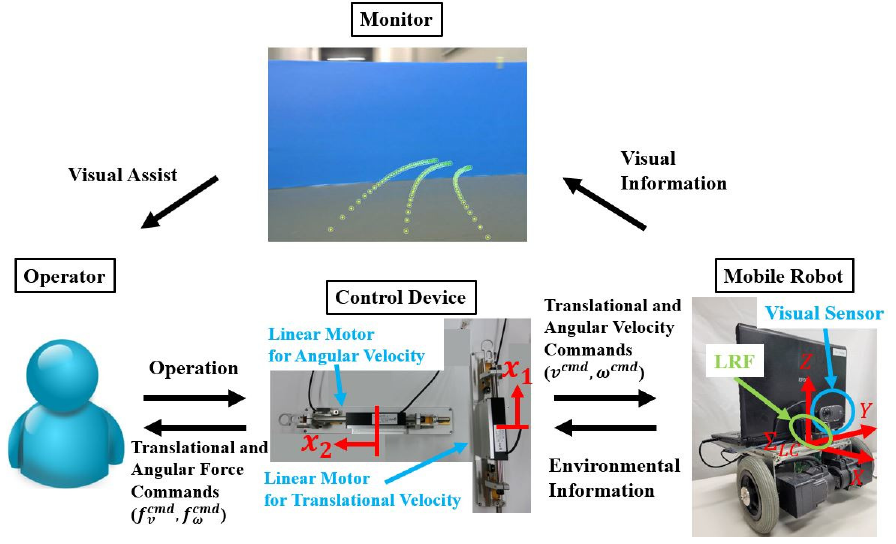
Figure 1. System configuration.